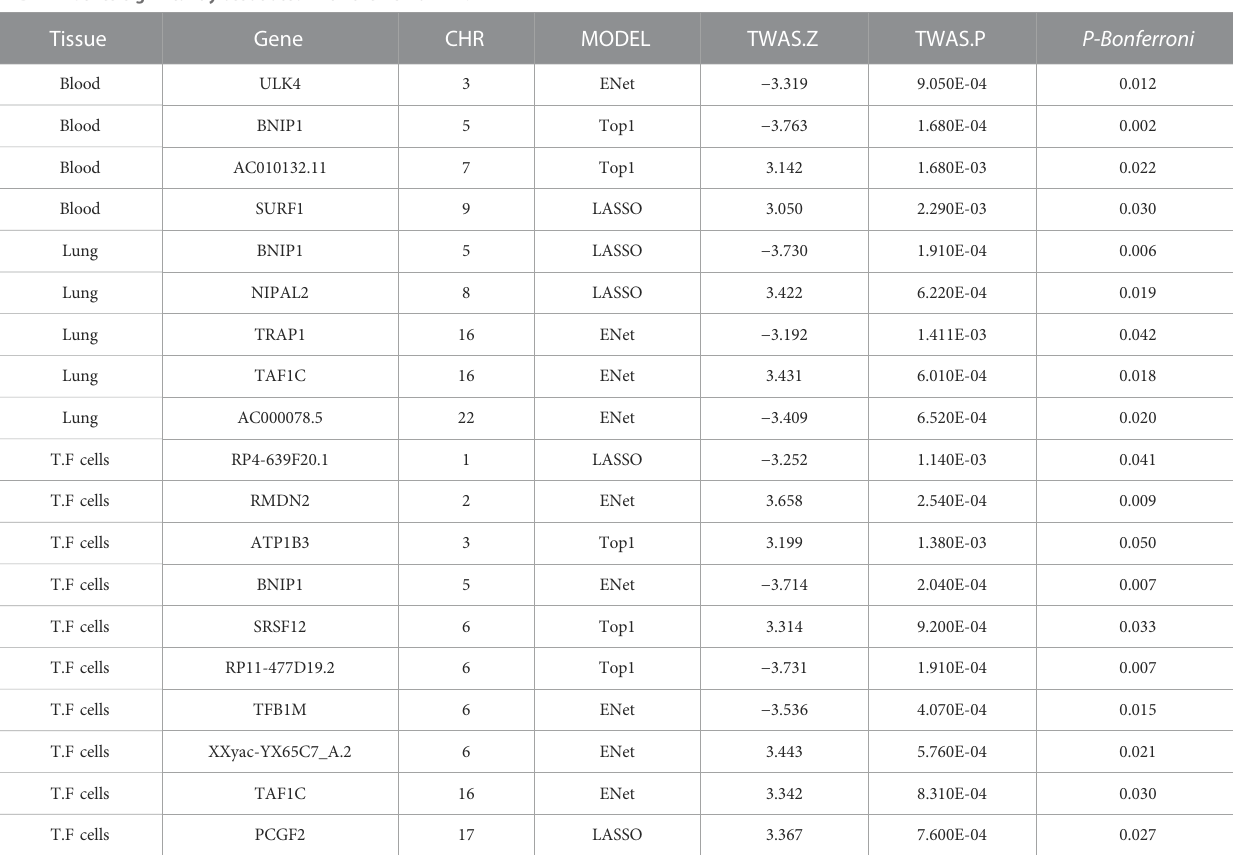
TABLE 1 Genes signi fi cantly associated with the risk of IAV.